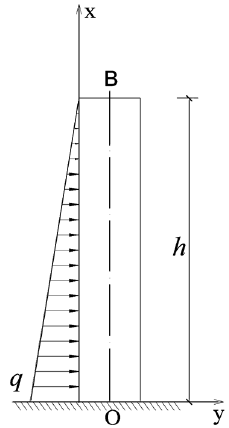
Fig. 8. Fitting relationship curve between composite elastic modulus and elastic modulus of concrete